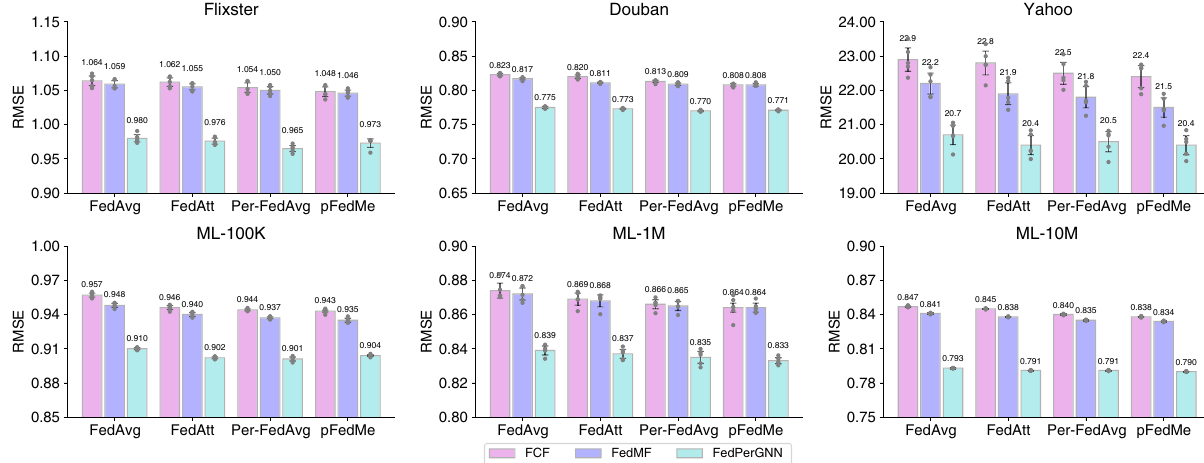
Fig. 3 In fl uence of using different federated update methods on model performance. The error bars represent mean results with 95% con fi dence intervals ( n = 5 independent experiments). The results show the effectiveness of FedPerGNN under different types of federated model update methods, and can slightly bene fi t from using more sophisticated ones.